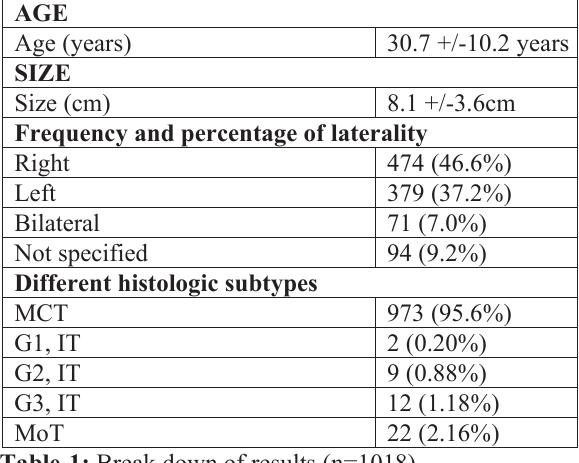
Table-1: Break down of results (n=1018)